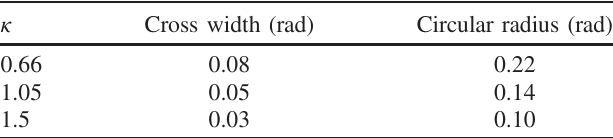
TABLE I. Parameters of the block used to estimate the measurement accuracy estimates shown in Fig.